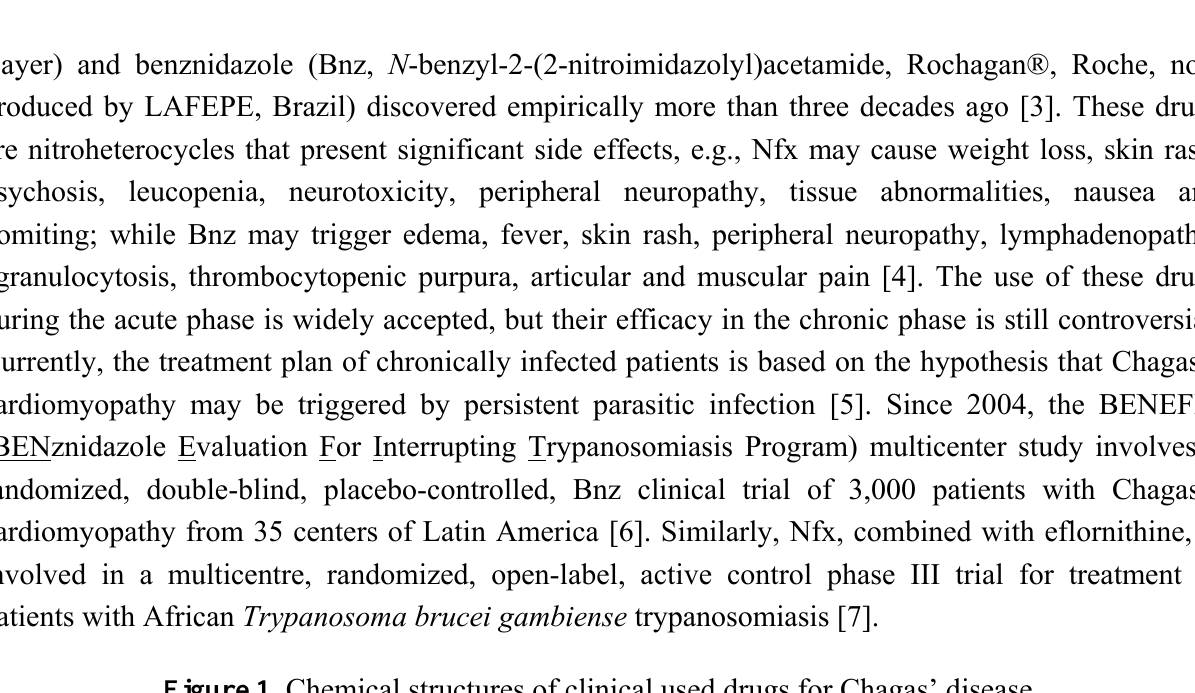
Figure 1. Chemical structures of clinical used drugs for Chagas’